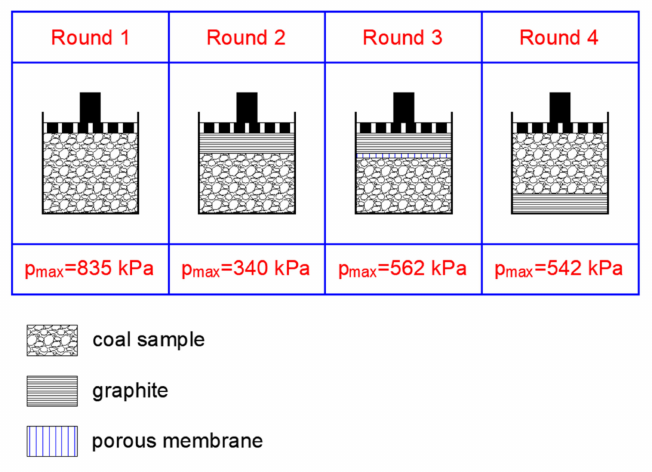
Figure 8. Schematic diagram of the experiment simulating various possibilities of the compression of the unplasticized part of the coal charge and the migration of the plasticized coal matter into layers adjacent to the plastic layer (explanations concerning particular rounds have been given in the text). Table 4. Influence of the migration effect of the plasticized coal matter and the bulk density of the graphite layer on the maximal value of coking pressure registered during the coking test of samples of the Borynia and H. Robert